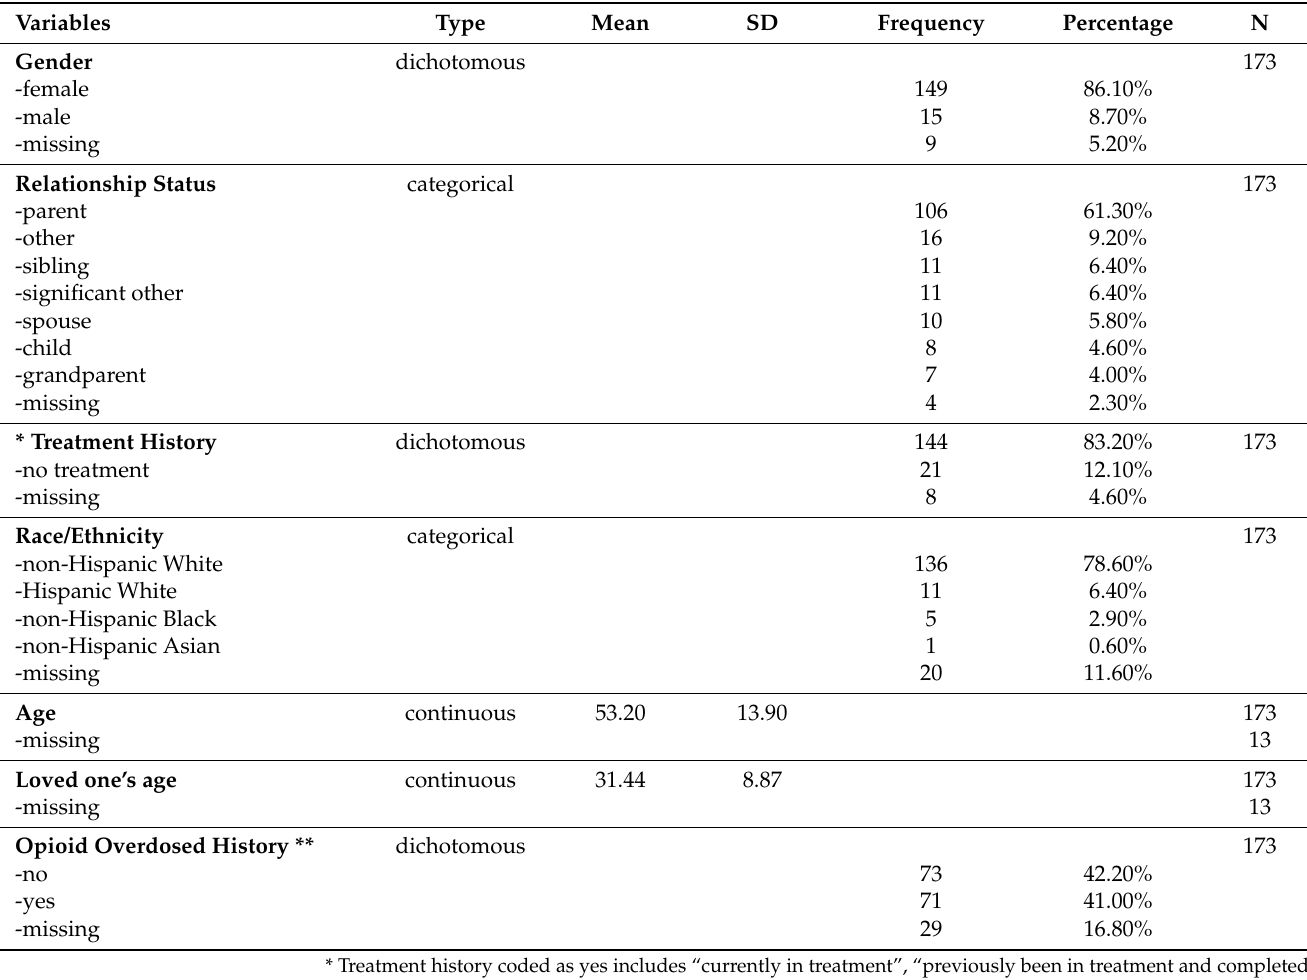
Table 1. Descriptive analyses of